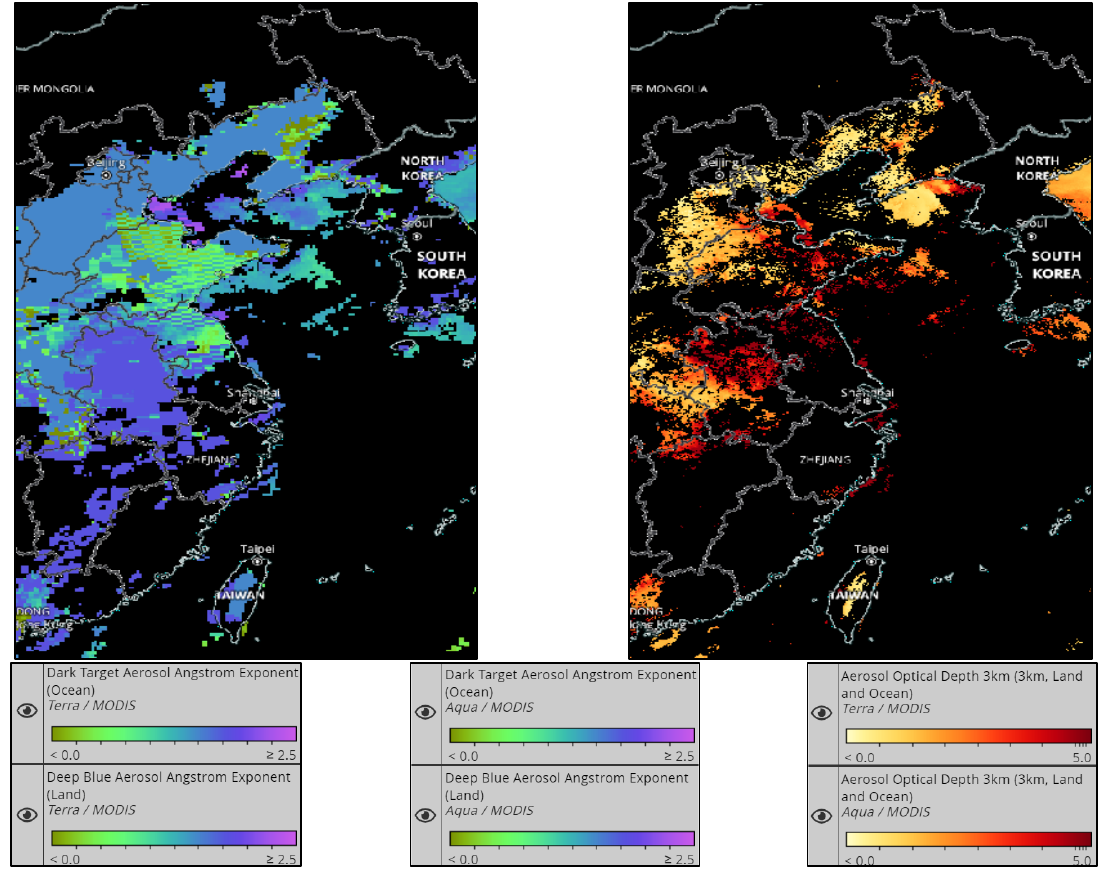
Figure 9. Satellite retrievals of Terra/MODIS and Aqua/MODIS from NASA Worldview merged Deep Blue Aerosol Angstrom Exponent (Land) and Dark Target Aerosol Angstrom Exponent (Ocean) are shown on the left; Aerosol Optical Depth 3km (3km, Land and Ocean) is shown on the right. ( a ) The Terra satellite passed over the Circum-Bohai-Sea region (CBSR) at 11:24 – 11:25 LST,